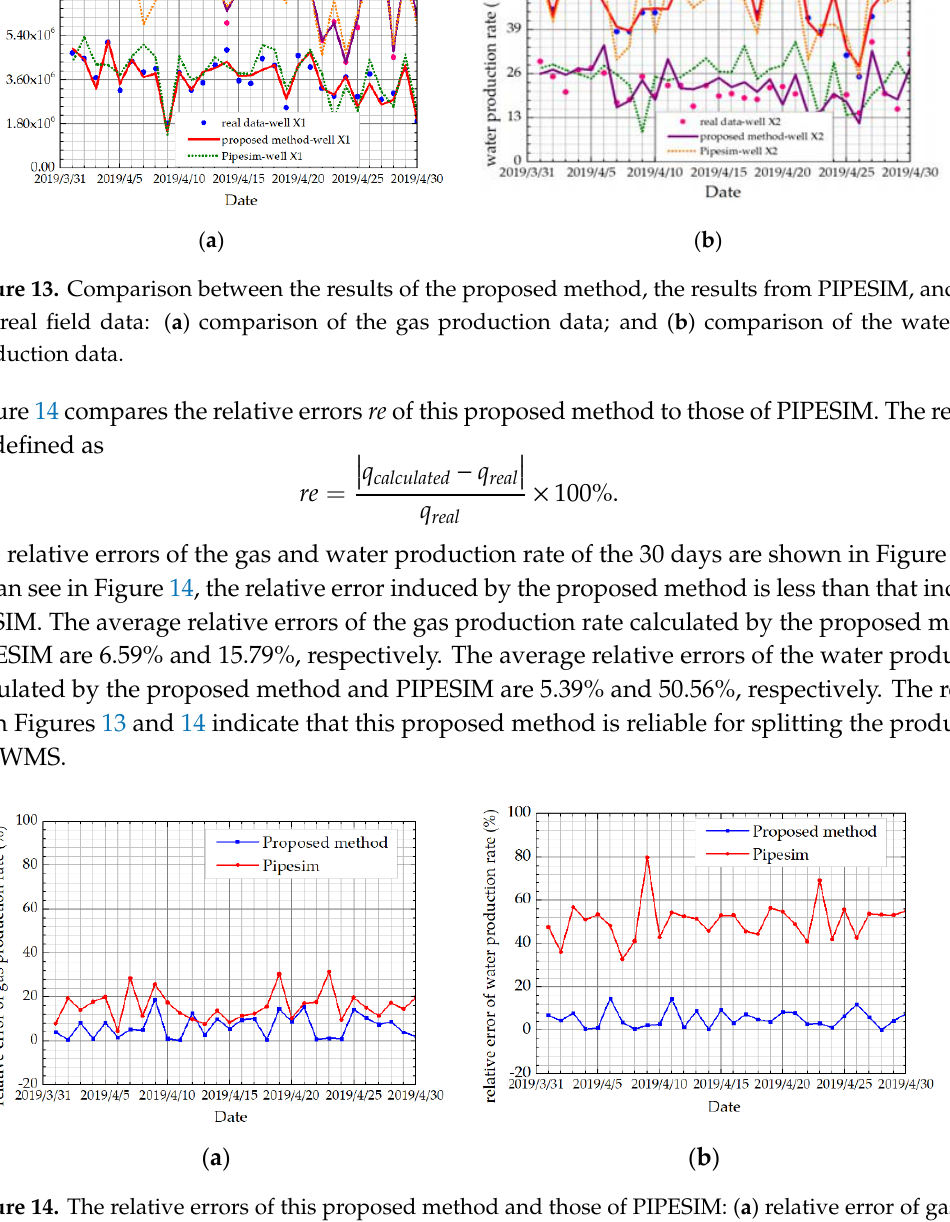
Figure 14. The relative errors of this proposed method and those of PIPESIM: ( a ) relative error of gas production rate; ( b ) relative error of water production rate.